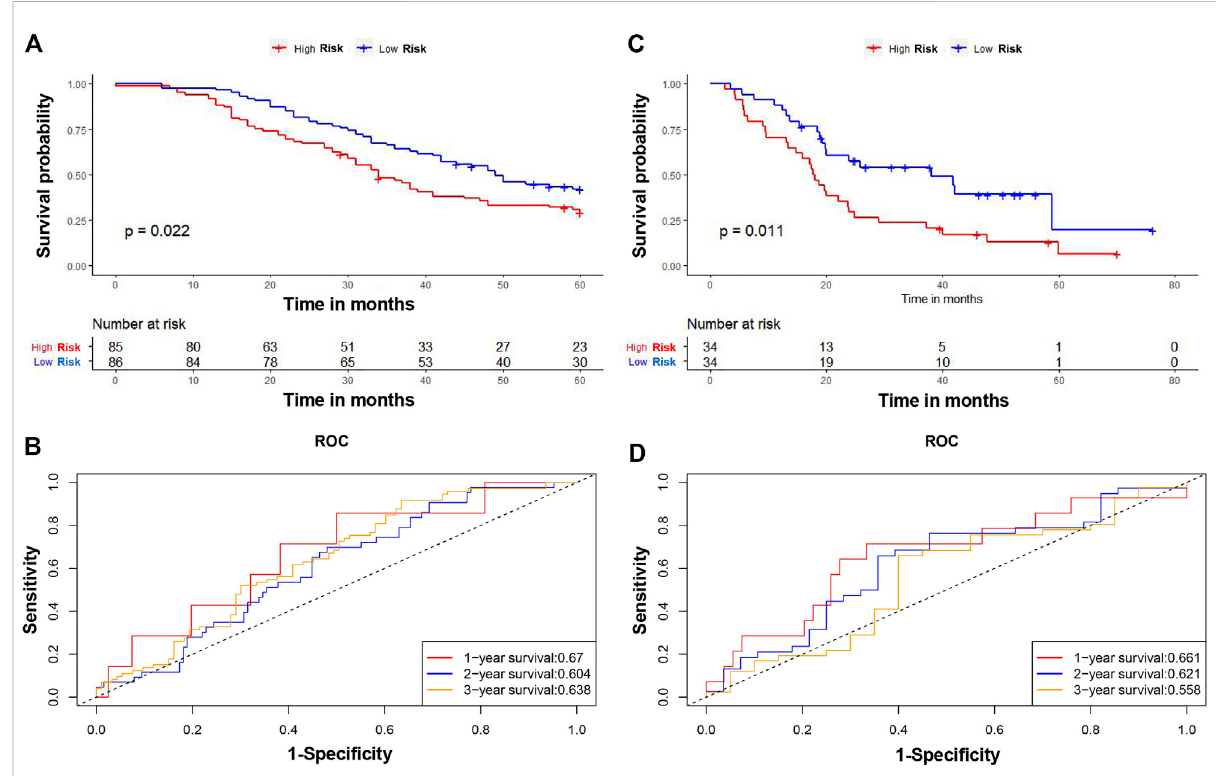
FIGURE 7 Veri fi cationoftheCAFs-relatedsignature.TheKaplan-MeiersurvivalcurvesofOSbetweenhighandlowriskscoregroupsinGSE159216 (A) and GSE72968 (C) . The time-dependent ROC curves of the prognostic signature for 1-, 2-, and 3-year overall survival in GSE159216 (B) and GSE72968 (D) .